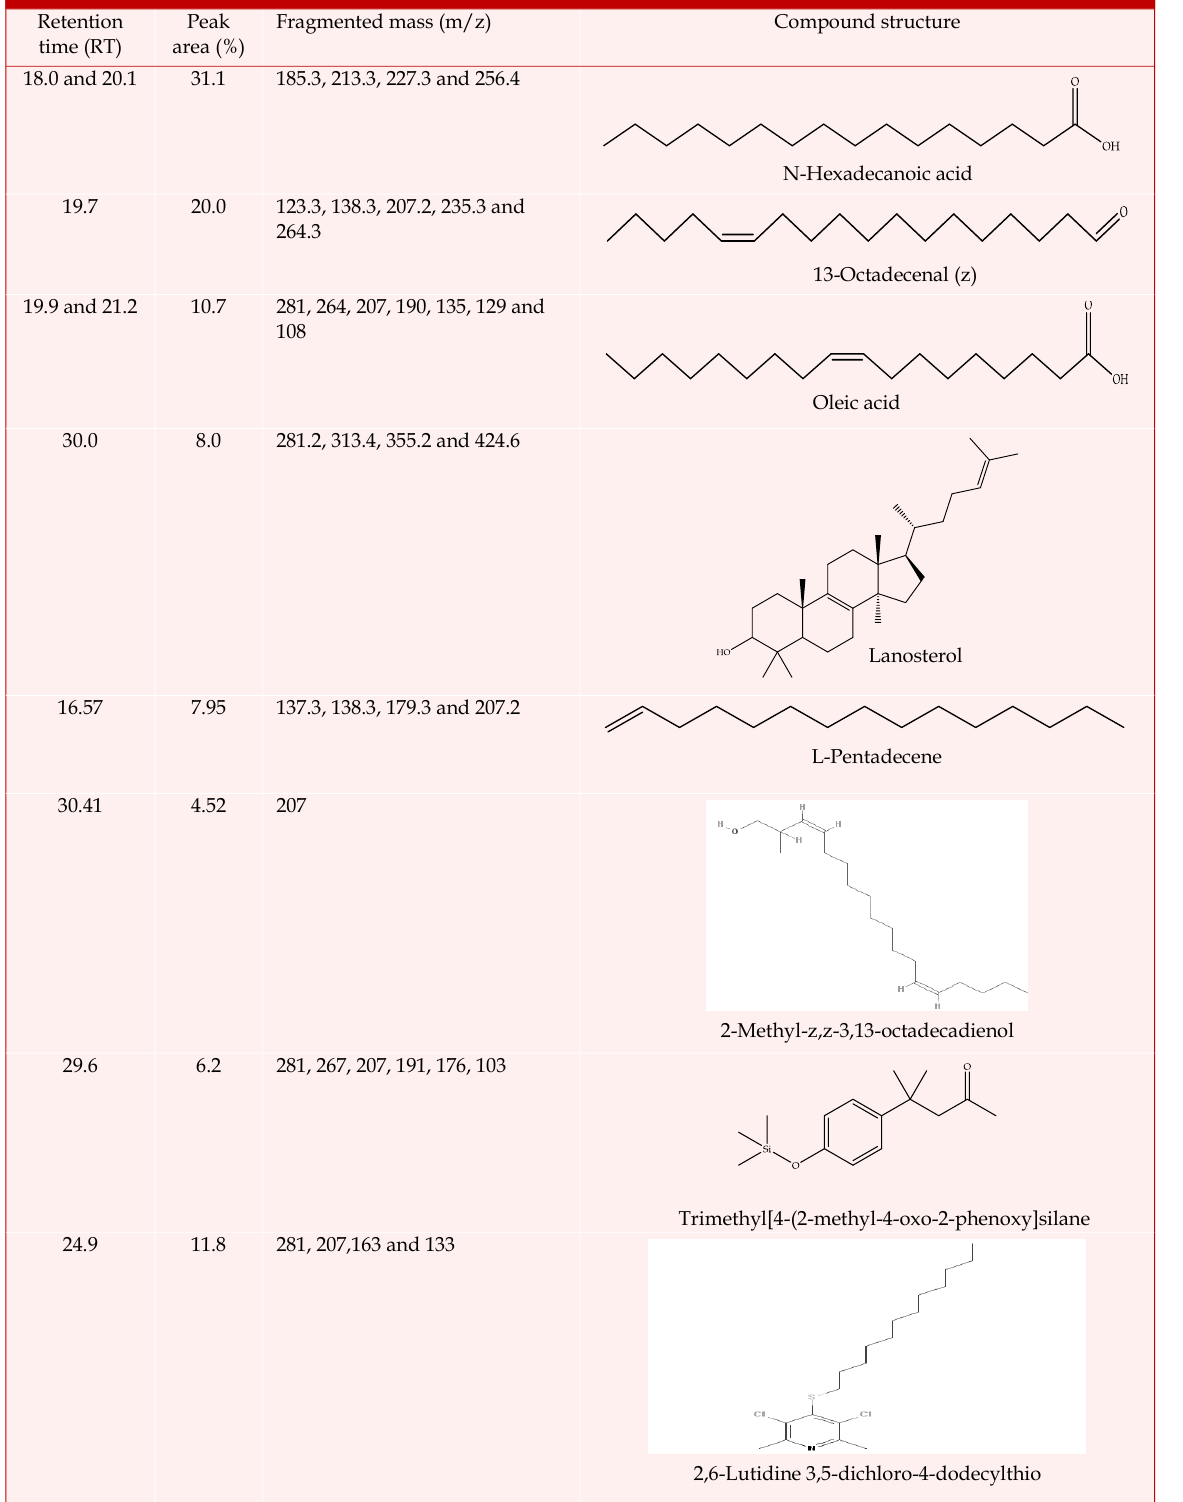
Identification of various compounds available in crude